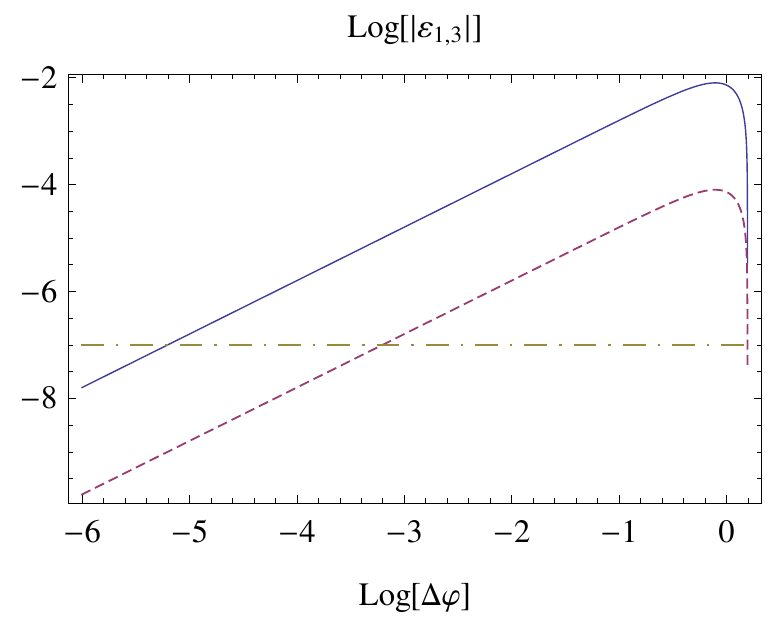
Figure 1. Logarithm (base 10) of the absolute value of the decay asymmetry ε 1,3 as a function of logarithm (base 10) of ∆ ϕ for | g 32 | = 1 (solid line) and | g 32 | = 0.1 (dashed line) in the case when g 11 = g 21 = g 12 = g 22 = 0 and M 2 = 10 · M 1